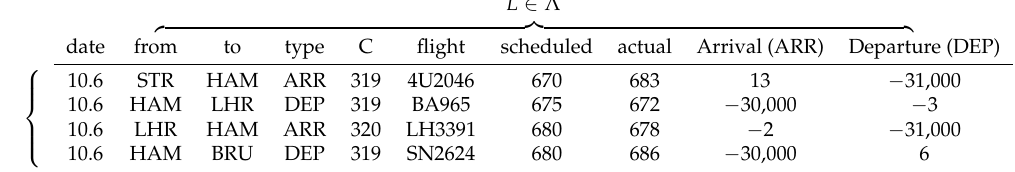
Table 2. Example data tuples for Hamburg Airport (HAM) to form L and l , 10.06.2013. L ∈